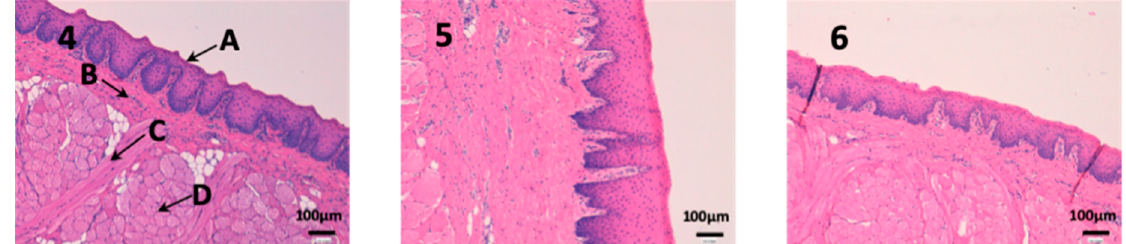
Figure 9. Photo 4: Histological image of untreated sublingual mucous observed at 400×; Photo 5: Histological image of sublingual mucous treated with CP-Solution observed at 400×; Photo 6: Histological image of sublingual mucous treated with CP-NPs observed at 400×. (A) Stratified flat keratinized epithelium; (B) own laminate. (C) muscle and (D) collagen fibers.